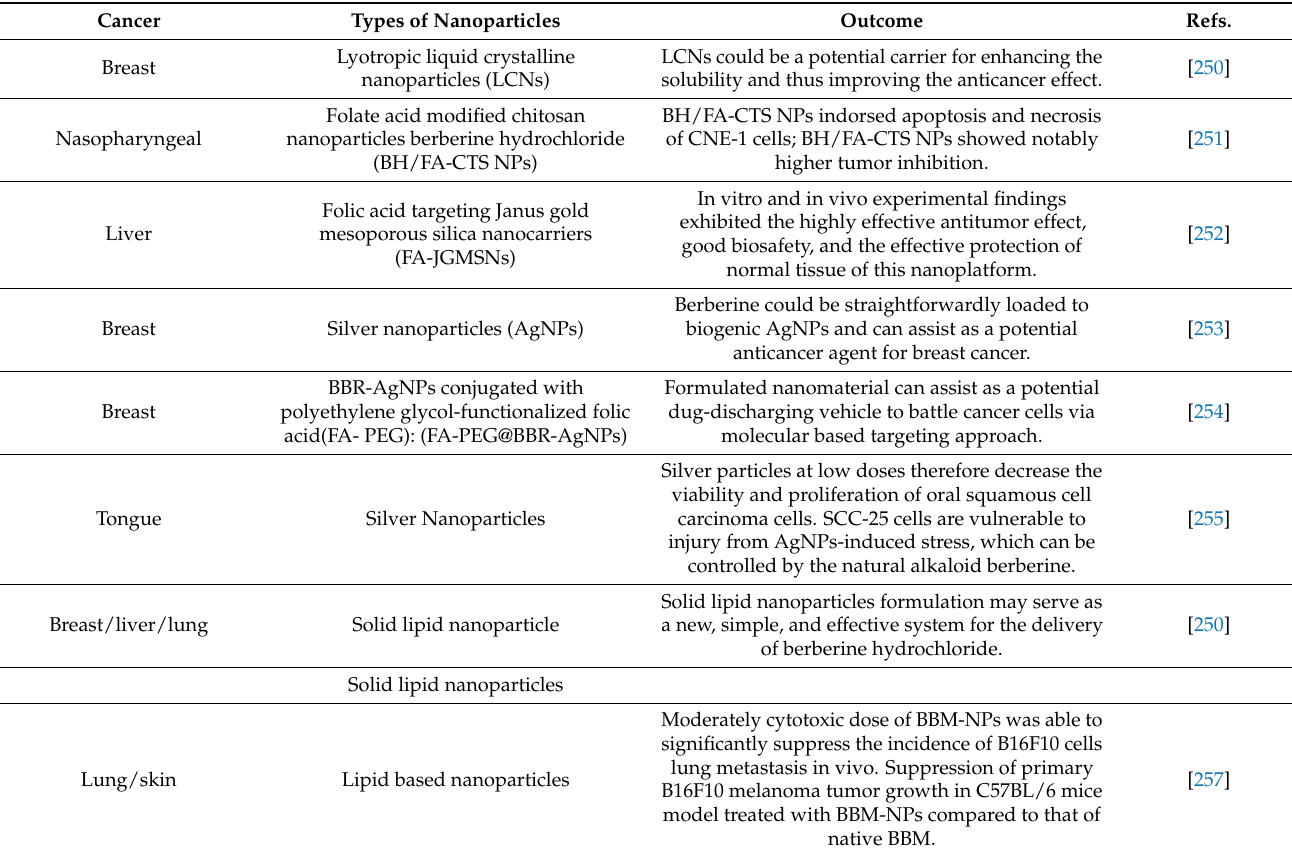
Table 4. Strategies to enhance berberine